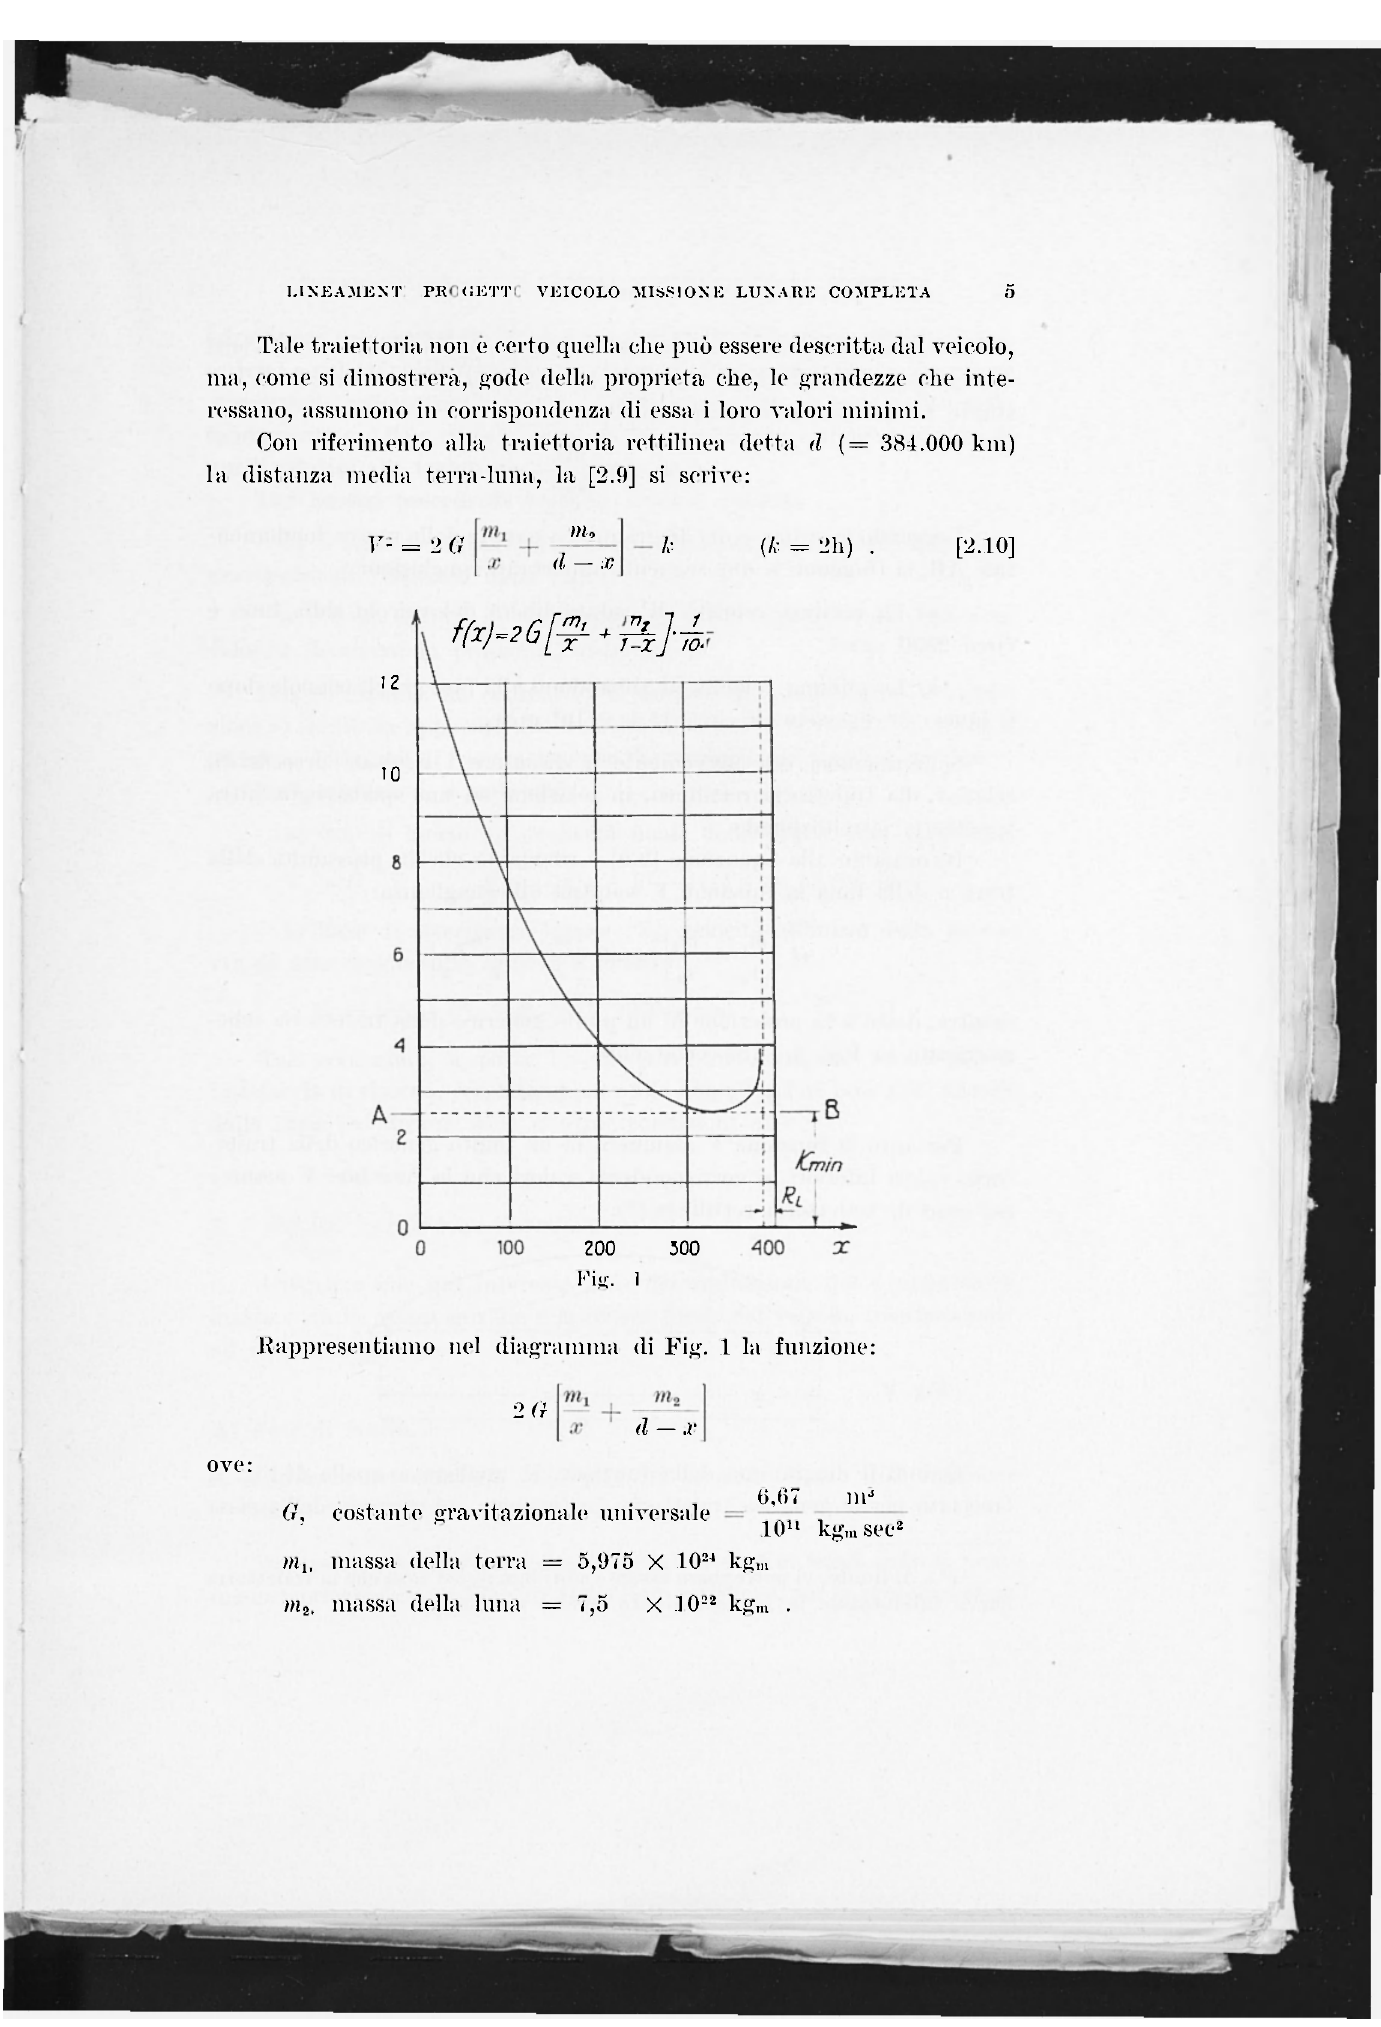
Eappresentiamo nel diagramma di Fig. 1 la